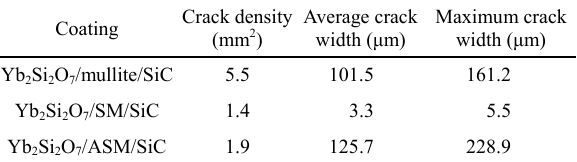
SiC coatings-coated C f /SiC samples after 360-min corrosion in the burner rig test at 1673 K